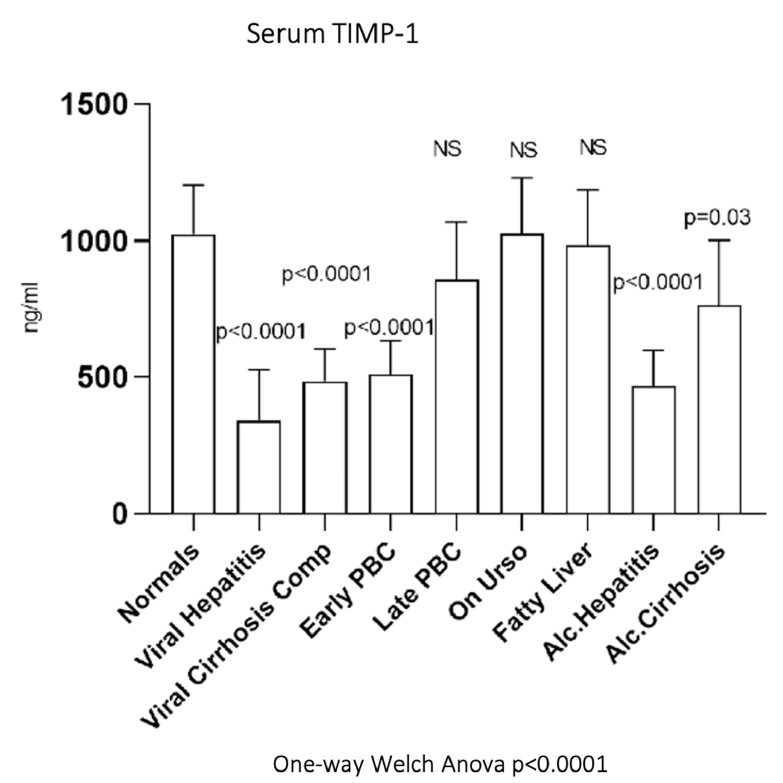
Figure 8. Serum MMP-9 in all studied groups.